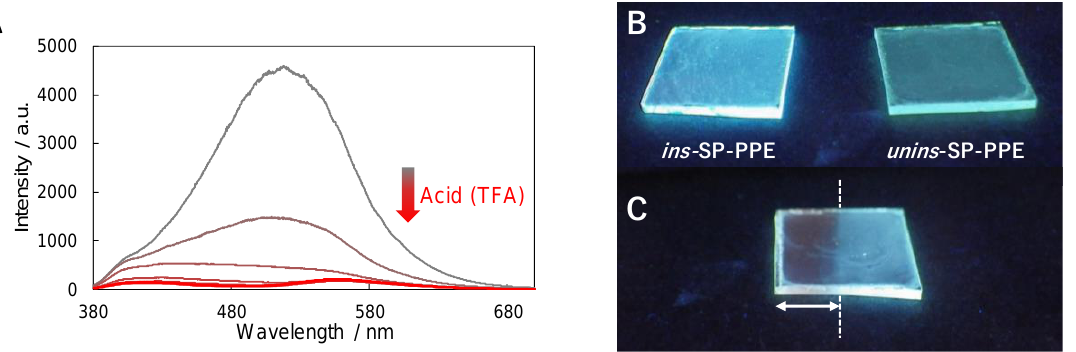
Figure 4. ( A ) Emission spectra of ins -SP-PPE upon adding different amounts of TFA (0–0.2 M). The solution of ins -SP-PPE was excited at 362 nm. Photographs under UV irradiation at 365 nm of ( B ) ins -SP-PPE and unins -SP-PPE films on a glass substrate and ( C ) fluorescence quenching of ins -SP-PPE before (right side) and after (left side) dipping in aqueous 0.1 M HCl for 10 s. The double-headed arrow marks the dipped region of the film.